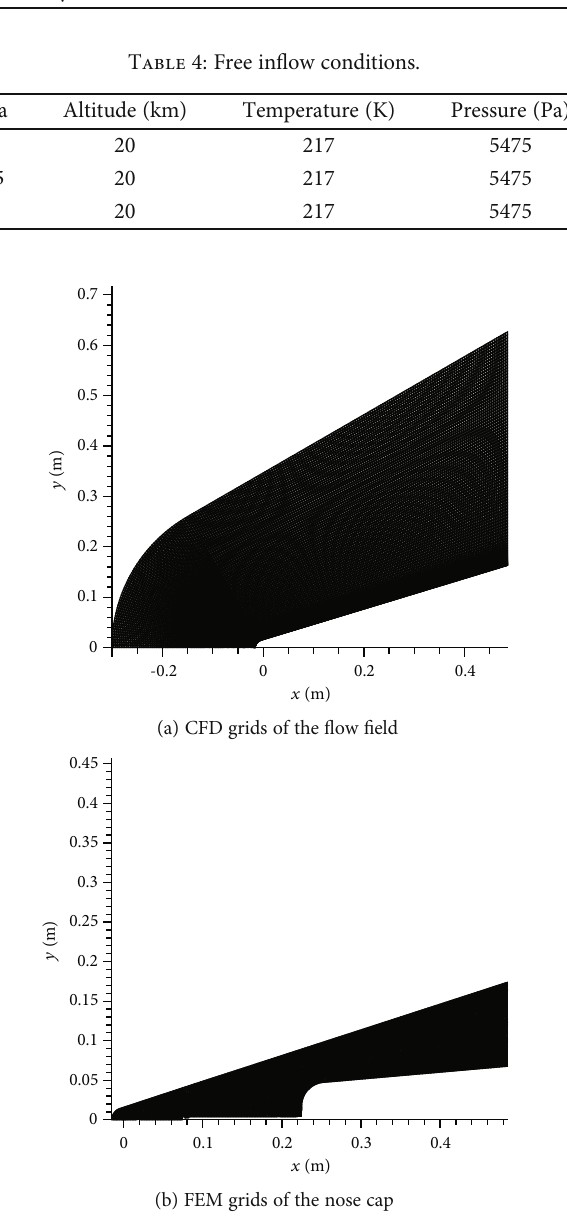
Figure 10: Grids of the computational domain.